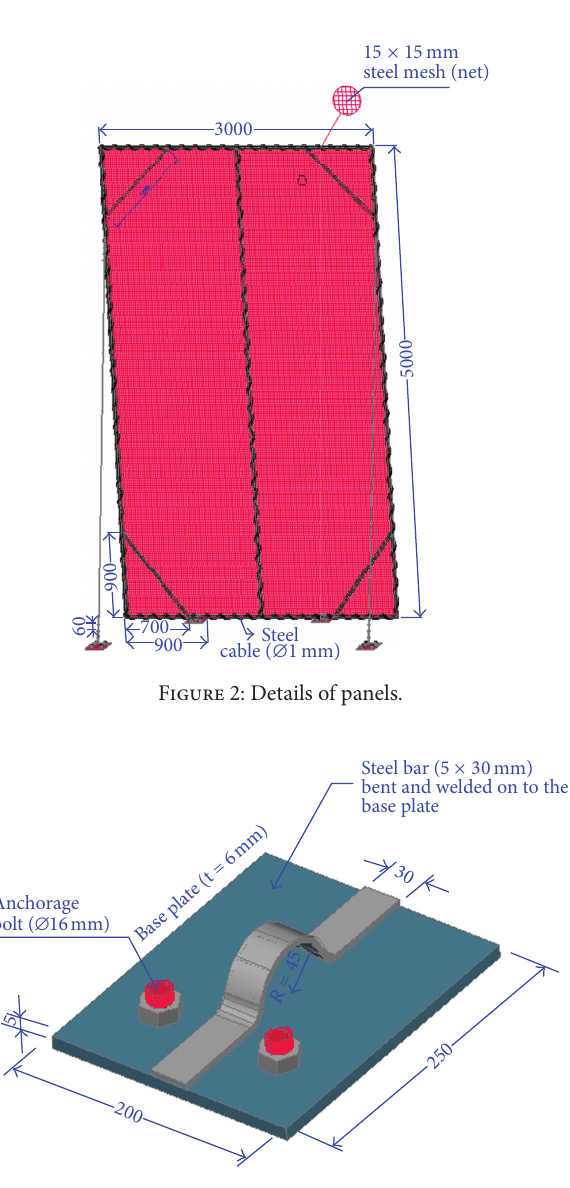
Figure 3: Base plate of the panels.